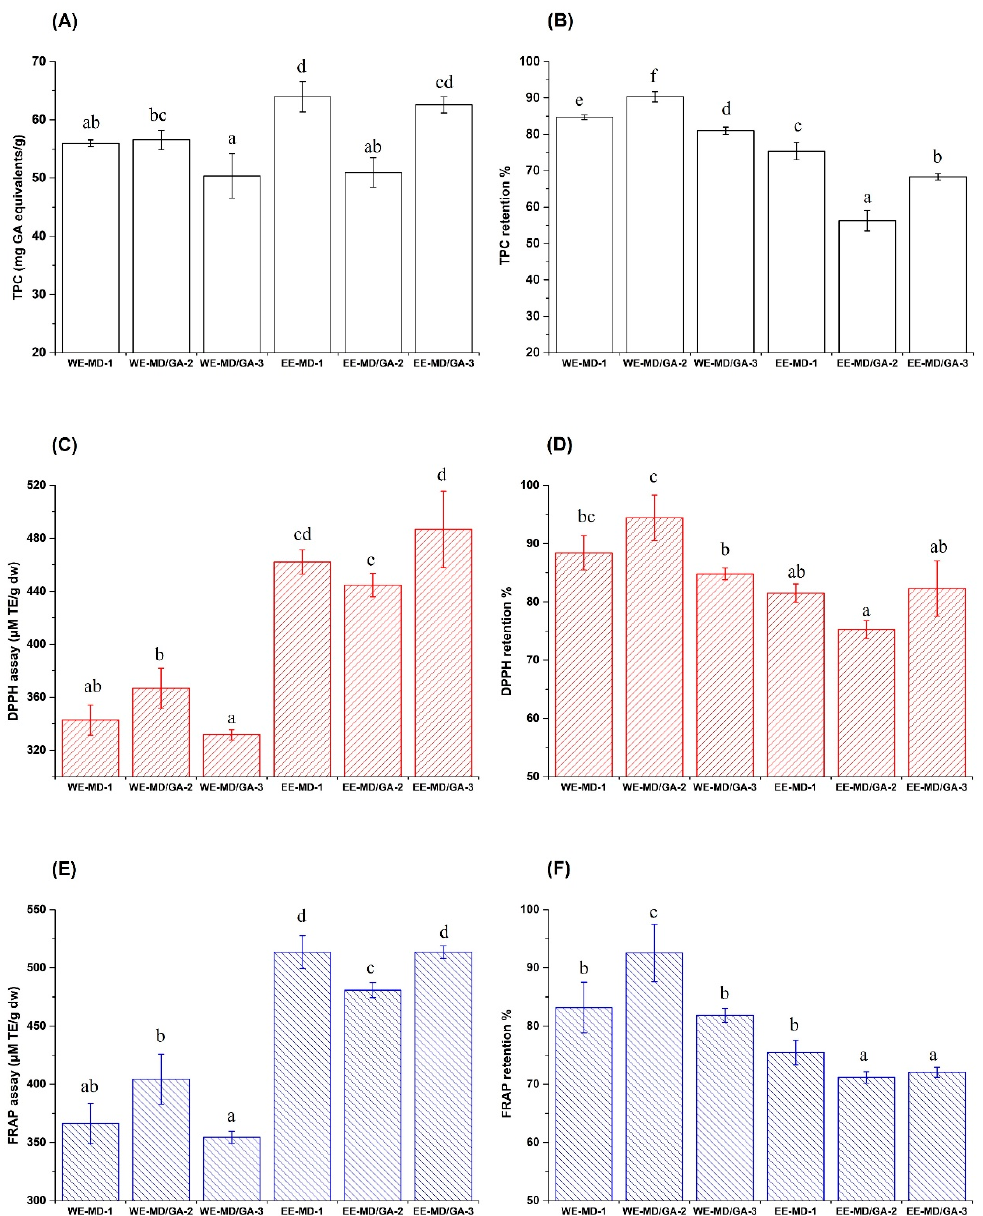
Figure 2. TPC and AOC of spray-dried C. paliurus extracts and their retentions after spray drying. ( A ) TPC of spray-dried powders; ( B ) The retention (%) of TPC after spray drying; ( C ) AOC of spray-dried powders evaluated by DPPH assay; ( D ) retention (%) of AOC after spray drying obtained by DPPH assay; ( E ) AOC of spray-dried powders evaluated by FRAP assay; ( F ) retention (%) of AOC after spray drying obtained by FRAP assay. (WE, aqueous extract; EE, ethanol extract; MD, malto-dextrin (10–13 DE); GA, gum acacia. The numbers indicate the wall materials ratio; 1 = only MD, 2 = MD:GA of 1:1 ratio, 3 = MD:GA of 1:3 ratio). Different letters (a, b, c, d, e, f) in the figure indicate significant differences at the level of p <